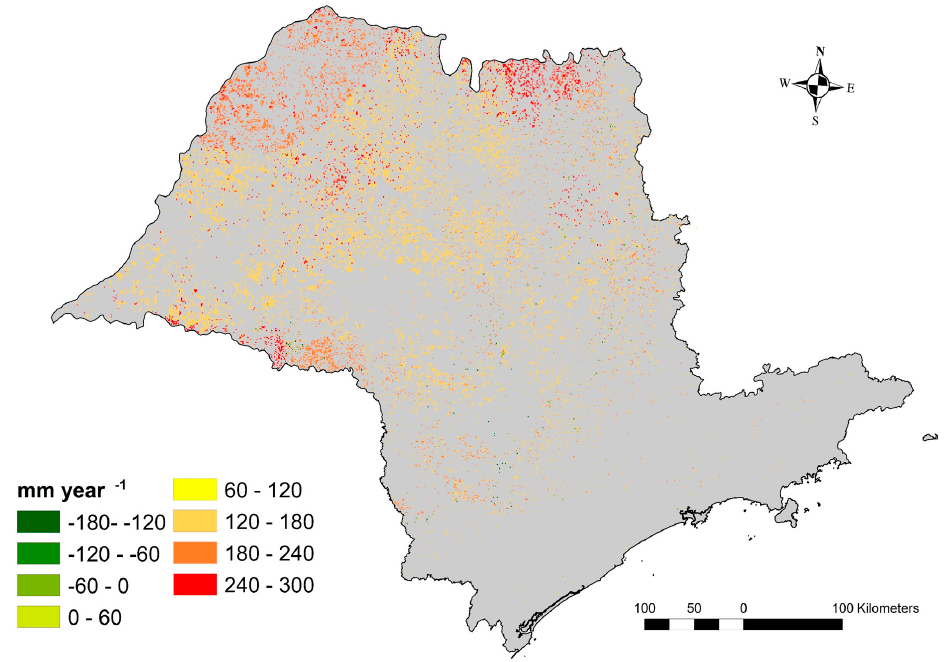
Figure 5. Di ff erence in the annual water shortage between sugarcane and land use / cover prior to Figure 5. Difference in the annual water shortage between sugarcane and land use/cover prior to conversion in the time period of 2005 to conversion in the time period of 2005 to 2015.